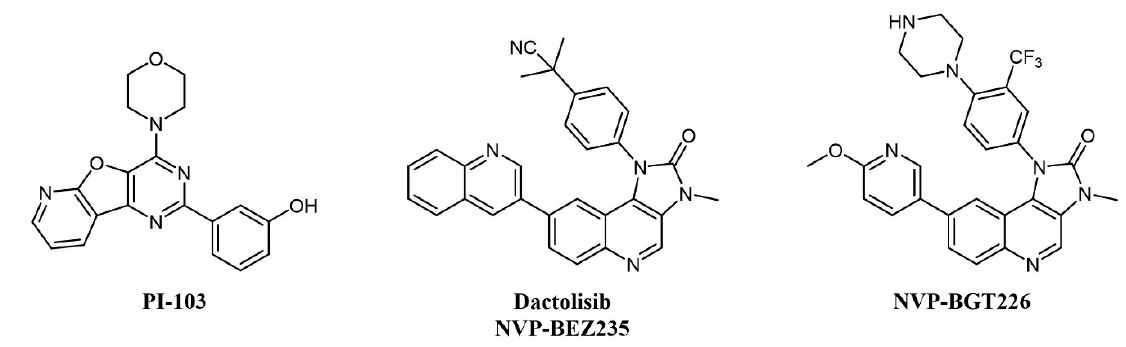
Figure 3. Chemical structure of dual mTOR/PI3K inhibitors used for AML treatment.